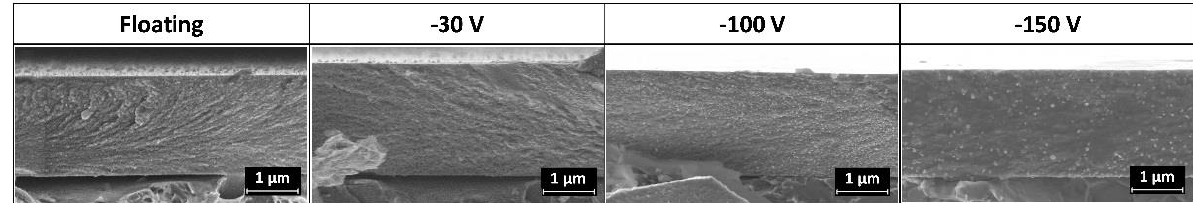
Figure 8. SEM micrographs of fracture cross sections of the samples from the bias voltage series (HiP-0.4-bias, MoAg35).